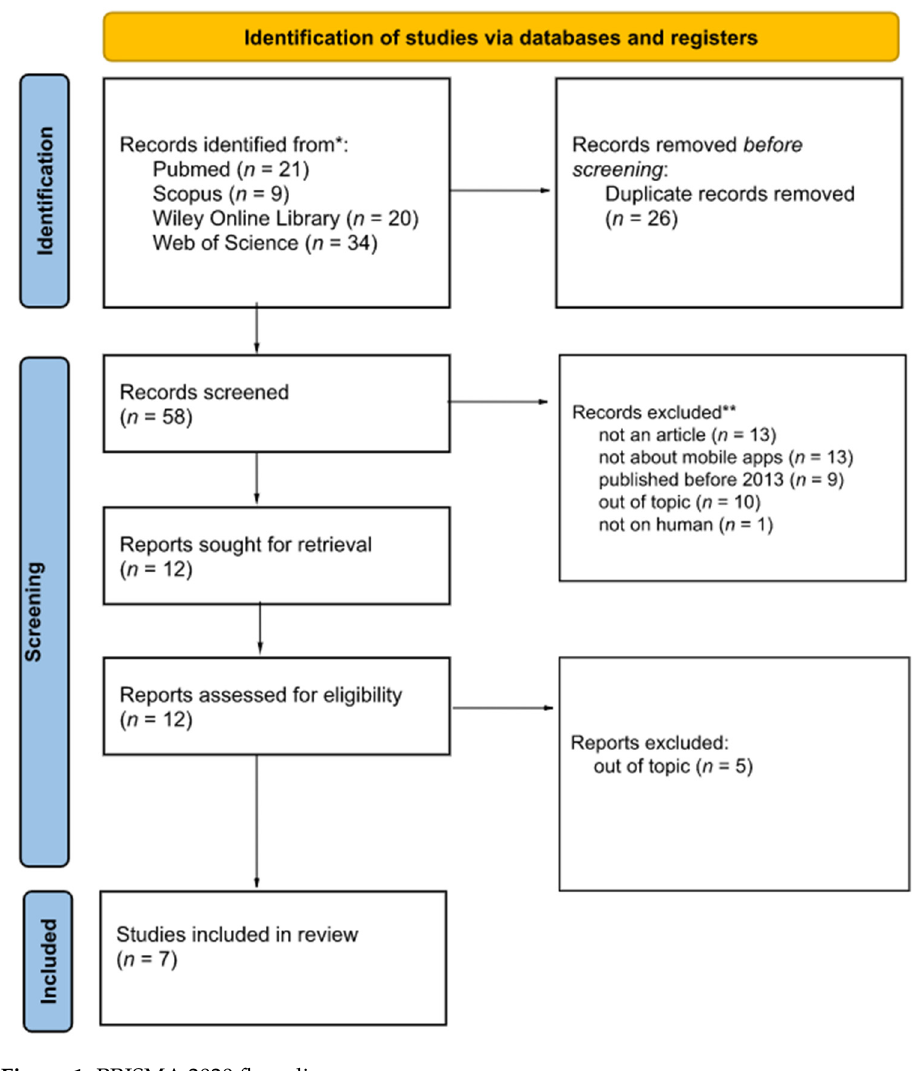
Figure 1. PRISMA 2020 flow diagram.